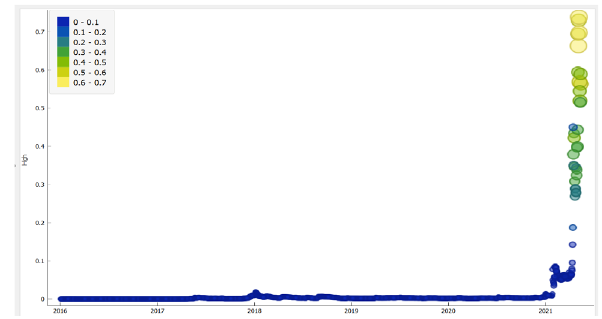
Fig. 3. Data Visualization of high price of Dogecoin